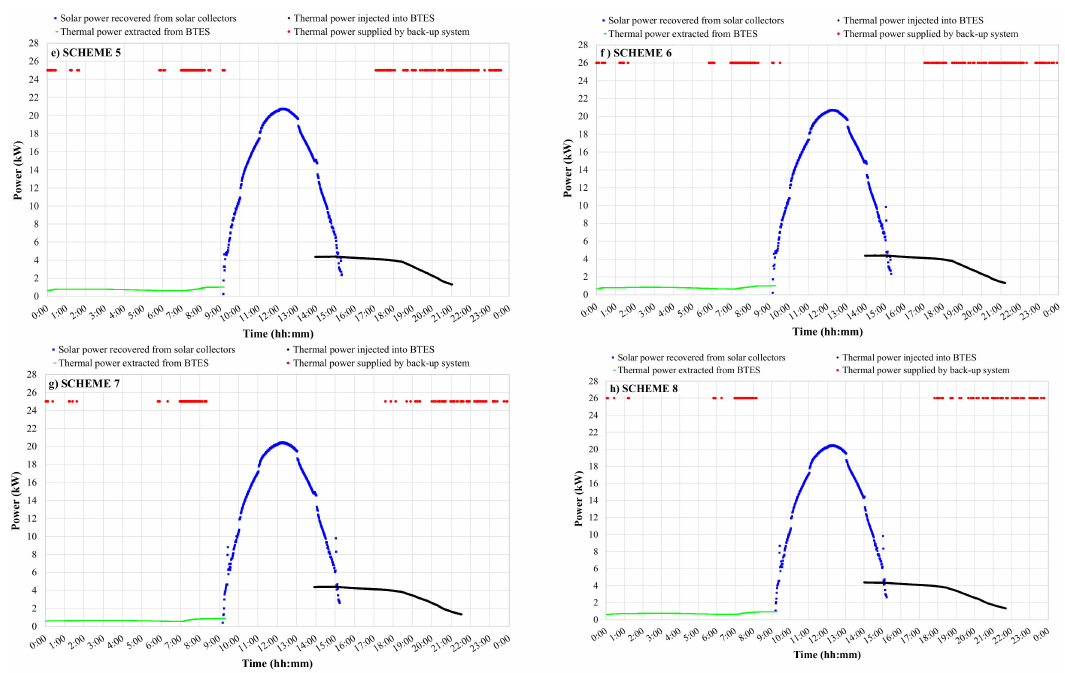
Figure 6. Main thermal energy flows during a typical daily operation (1 February of the fifth simulation year) of the 8 configurations: SCHEME 1 ( a ), SCHEME 2 ( b ), SCHEME 3 ( c ), SCHEME 4 ( d ), SCHEME 5 ( e ), SCHEME 6 ( f ), SCHEME 7 ( g ) and SCHEME 8 ( h